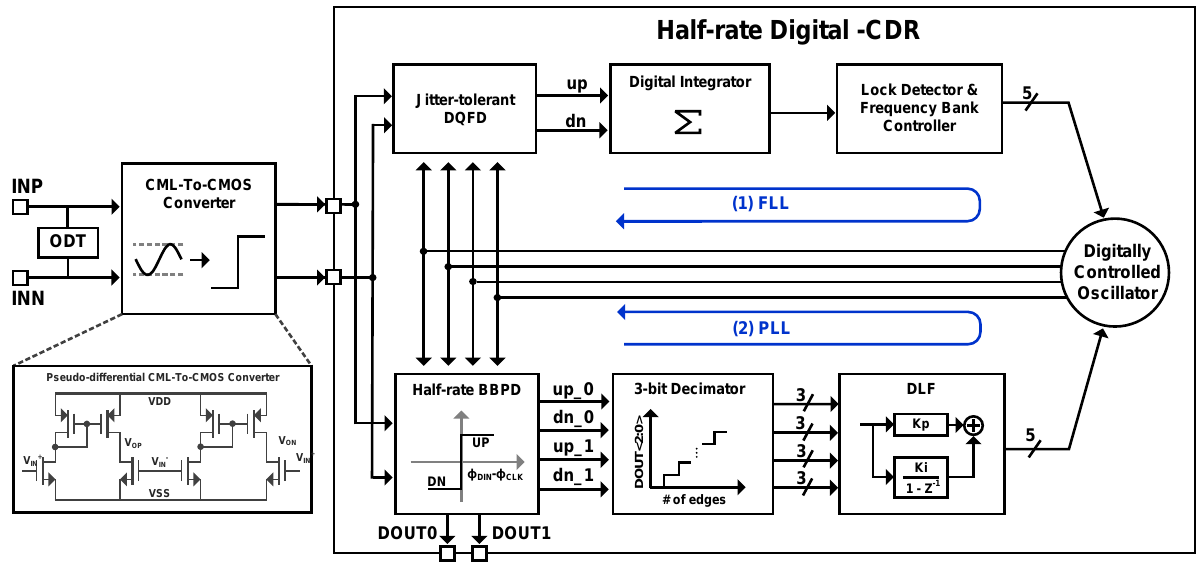
Figure 2. Receiver architecture including a CML-to-CMOS converter and a digital